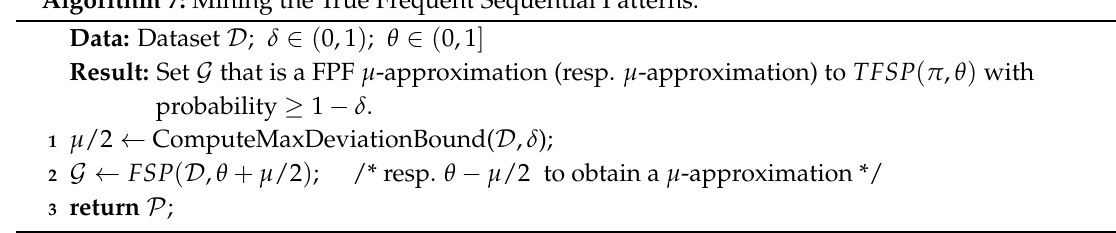
Algorithm 7: Mining the True Frequent Sequential